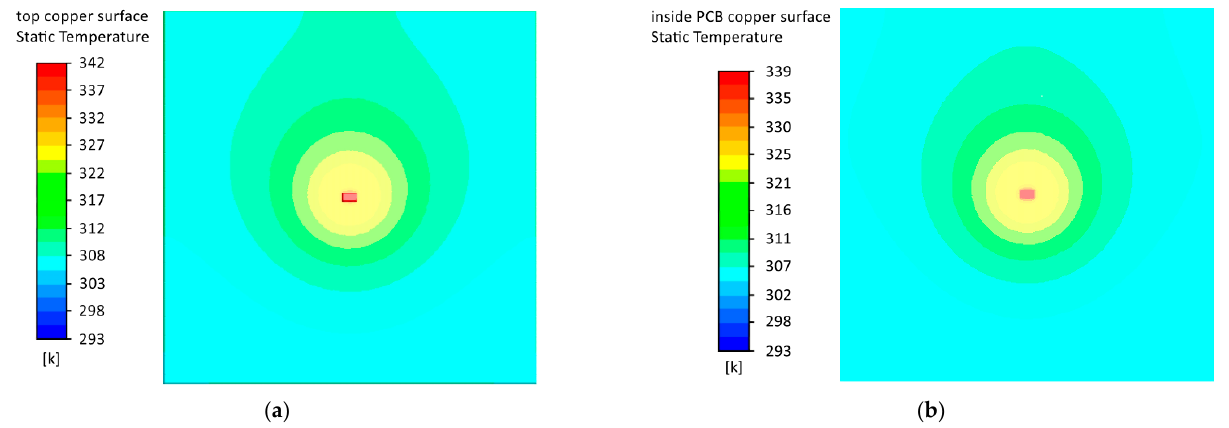
9 of 12 Figure 9. Dependence of the component temperature on the airflow rate in models without a copper layer. From a practical point of view, the existing equipment cooling systems produced a flow rate of no more than 15 (cid:2923) (cid:2929) . However, in real conditions, the airflow velocity in elec- tronic equipment does not exceed 3 (cid:2923) (cid:2929) . Therefore, the following conclusion could be drawn: in most use cases, namely in conditions of natural cooling and low-performance forced cooling, the built-in component will have a lower temperature compared to the surface one, which would positively affect its reliability and the reliability of the electronic device as a whole. Let us consider models with a copper layer (Figure 10) and graphs of the component temperature dependence on the input flow rate (Figure 11). The introduction of a copper layer significantly reduced the temperature of the component and the temperature gradi- ent on the PCB. When the flow velocity of the blown air was less than 16 (cid:2923) (cid:2929) , the tempera- ture of the embedded component was lower than the temperature of the surface compo- nent, which was similar to models without a copper layer. Under natural cooling condi-